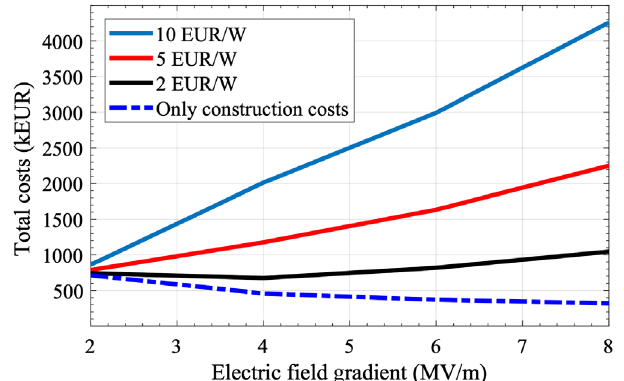
FIG. 19. The estimated total costs (construction and rf power source costs) of NIMMS QA-DTL as a function of the average axial electric field. The calculation has been performed based on three different rf costs of 2, 5, and 10 EUR/W. The dashed line shows only the costs related to the construction of the